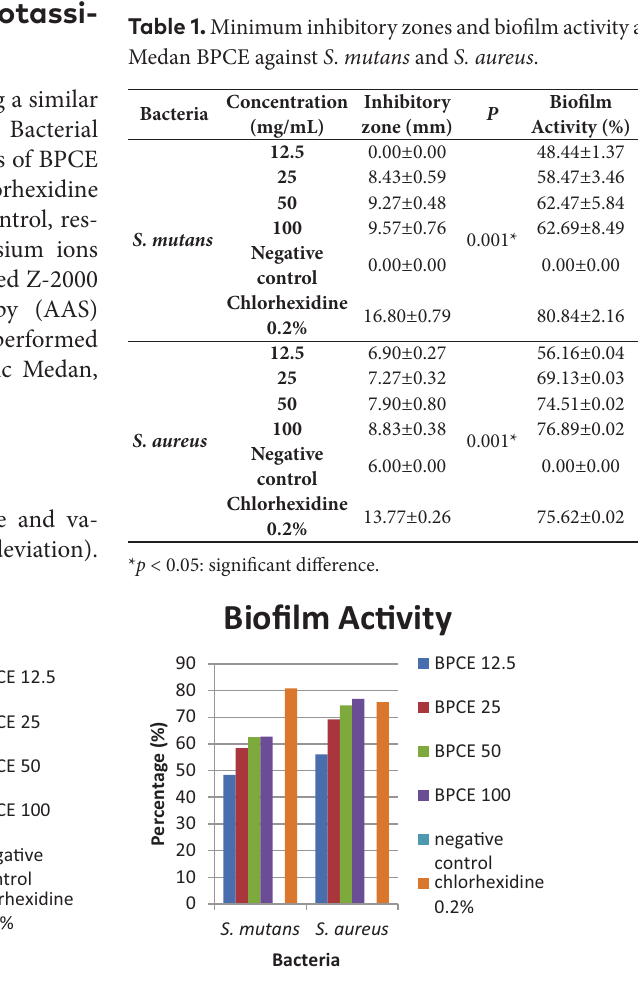
Figure 2. Minimum inhibitory zones and biofilm activity of BPCE against S. mutans and S. aureus at different concentrations. Each colour represents the millimetre and percentage from different concentrations of BPCE (mg/mL) in each